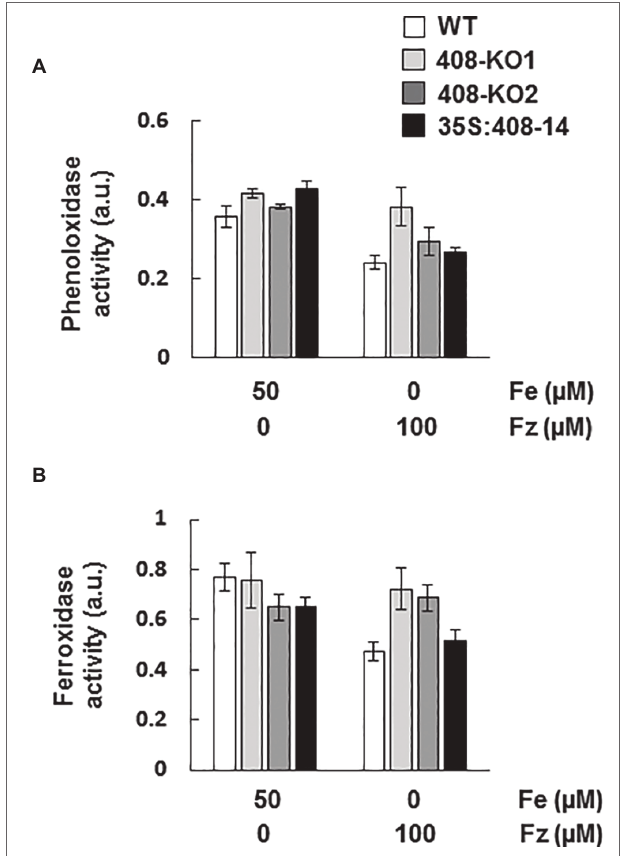
FIGURE 6 | Phenoloxidase and ferroxidase activities in the seedlings with altered miR408 expression. (A) Phenoloxidase and (B) ferroxidase activities in the gels from the 7-day-old wild-type (WT), 408-KO1, 408-KO2, and 35S:408-14 seedlings grown on 1/2 MS plates containing 50 μ M Fe citrate and 100 mM ferrozine. About 100 μ g of total protein extraction were used for each sample. The relative intensities of the bands corresponding to the LMCO expected MW are shown as arbitrary units (a.u.). Values are the means ± SD of three technical replicates. A representative quantification of at least three independent experiments is shown.